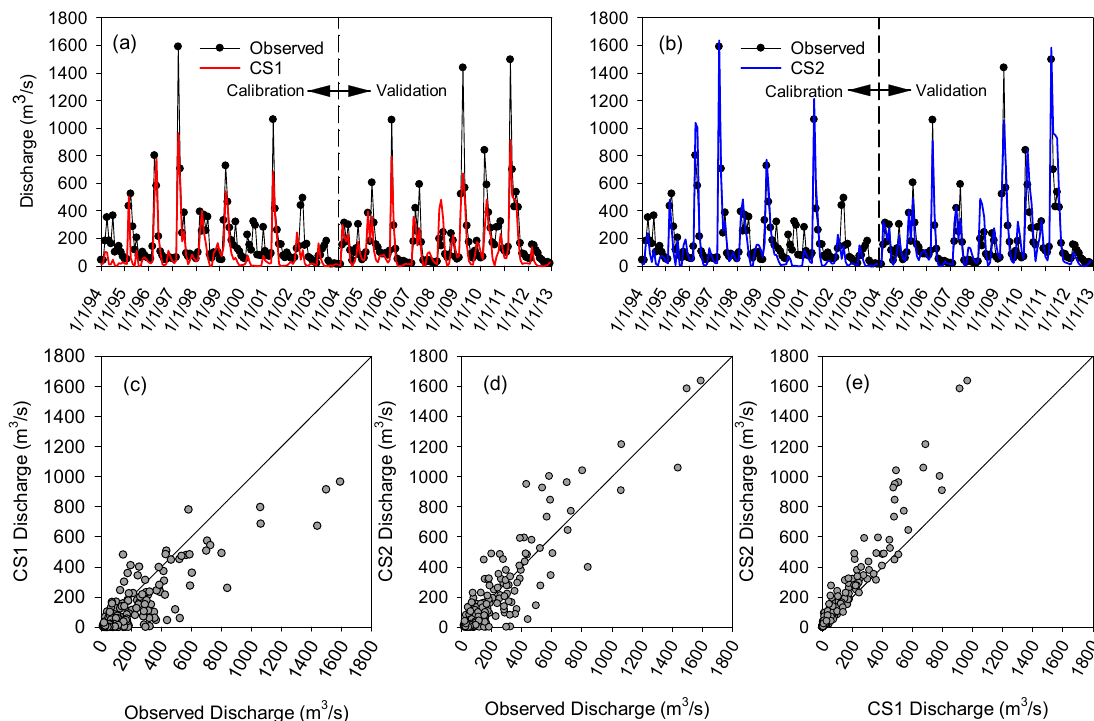
Figure 5. Observed versus simulated monthly discharges at the Grand Forks gauging station for ( a ) calibration scheme CS1 (traditional calibration scheme); ( b ) calibration scheme CS2 (wet-dry calibration scheme); ( c – e ) graphical comparisons of the observed and simulated discharges for CS1 and CS2.